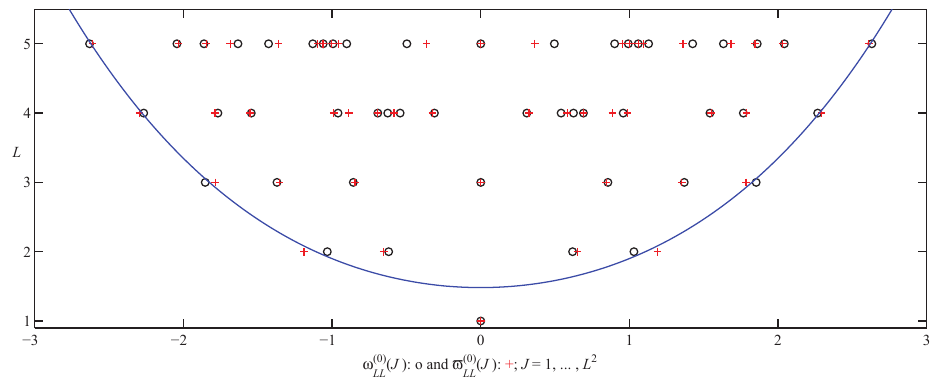
( 0 ) ( 0 ) Figure 2. (colour online) Eigenfrequencies ω and ω of undamped eigenmodes associated with LL LL ( 0 ) M ( 0 ) L = 1 to 5. The smooth curve ω ( L ) = 0.0159 L 4 + 0.4027 L 2 + 1.4825 fits the outer and M LL for LL data but is only used for purpose of illustrating that the eigenfrequencies appear unbounded as L → ∞ . However, dissipation ( E > 0) is eventually important and provides a bounding mechanism, as shown in Figure 3.